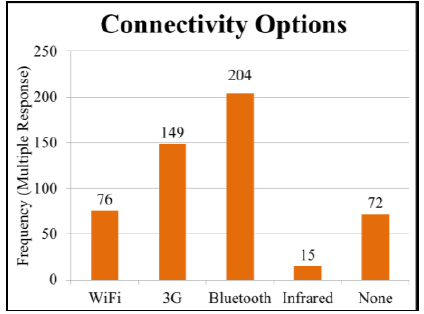
Figure 3. Connectivity options (Total multiple responses = 451